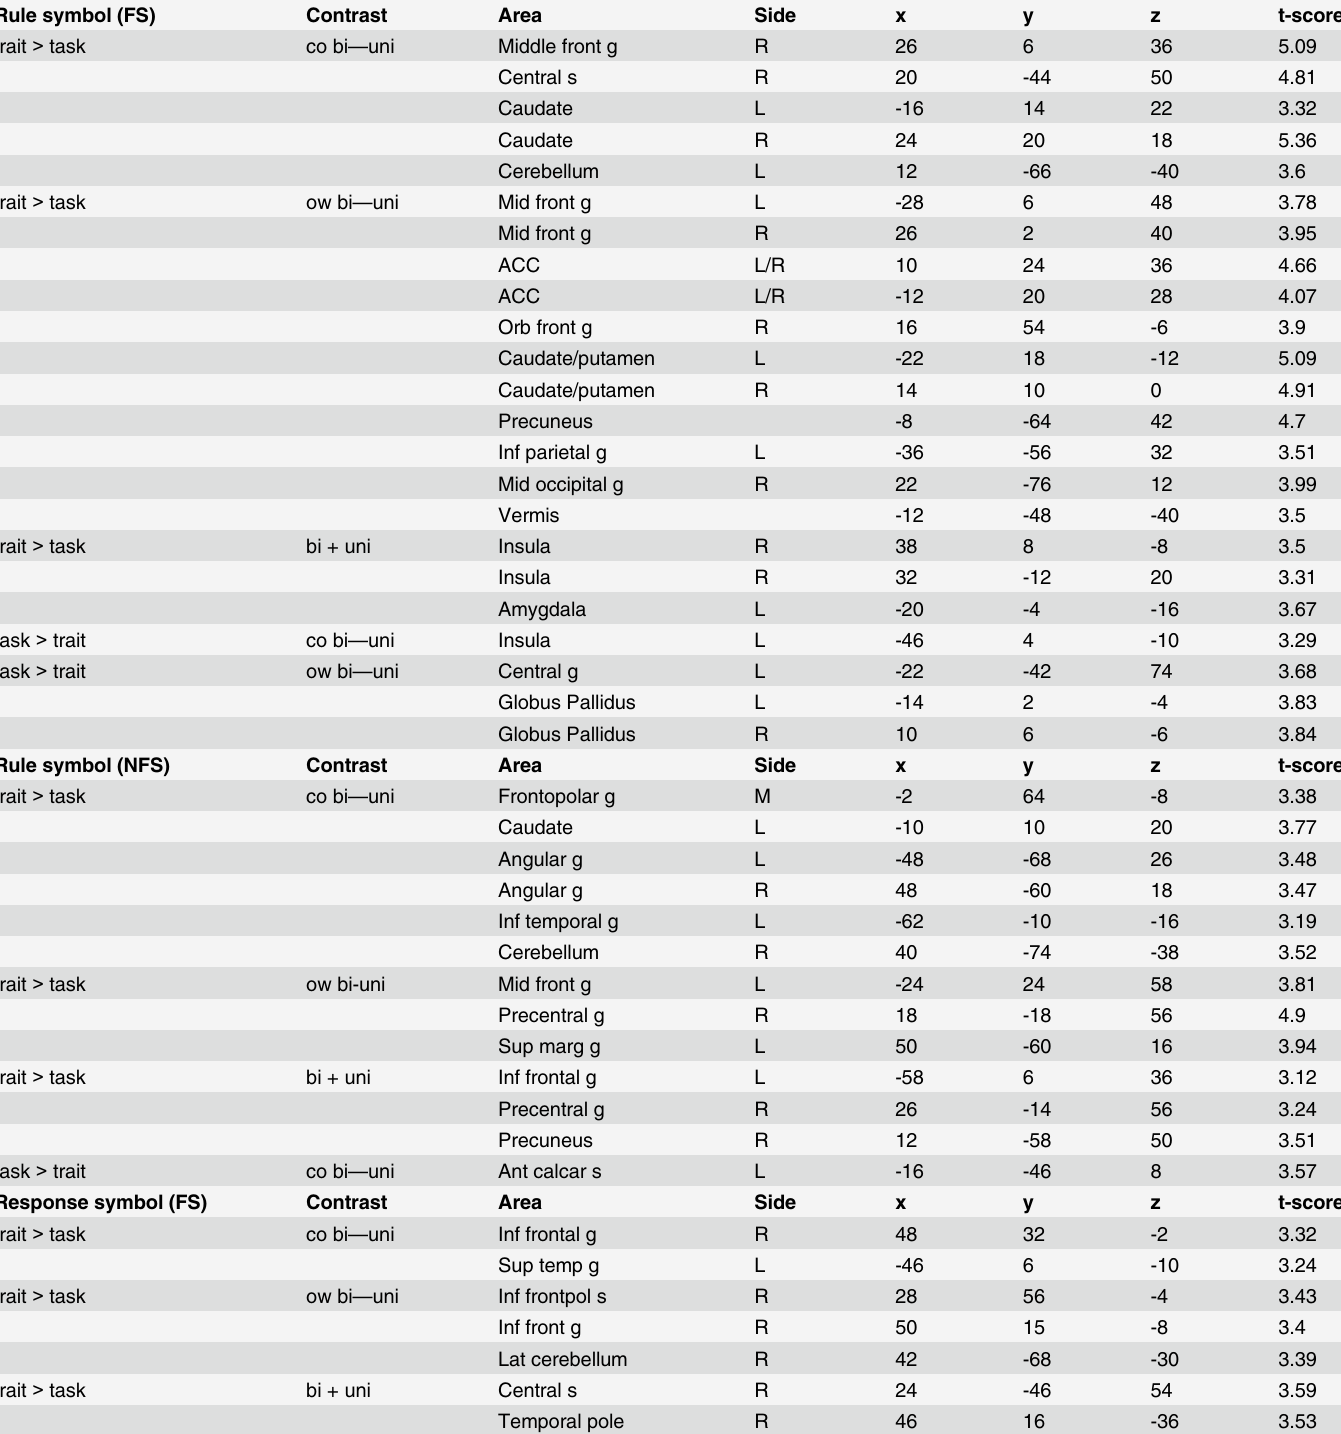
Table 3. Brain activations at a statistical threshold of p < 0.001 uncorrected. Brain activation at uncorrected (p < 0.001) statistics for feedback session (FS) and no feedback session (NFS) at the event of seeing the rule symbols and at the event of making a key press/seeing the feedback ‘ you are clever ’ and ‘ your choice was correct ’ , for bivalent trials (bi) and univalent trials (uni) trials. co — cross-over analysis, ow — one way